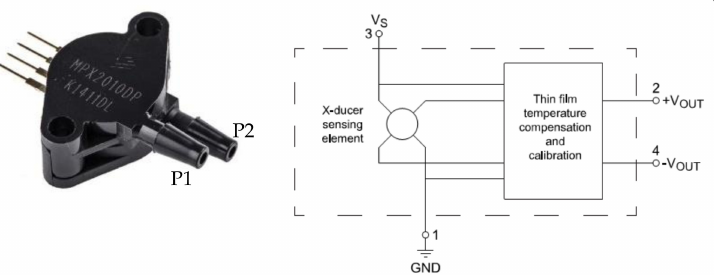
Figure 3. The MPX2010DP differential pressure sensor and its schematics. P1 and P2 are the pressure side and the vacuum side, respectively.